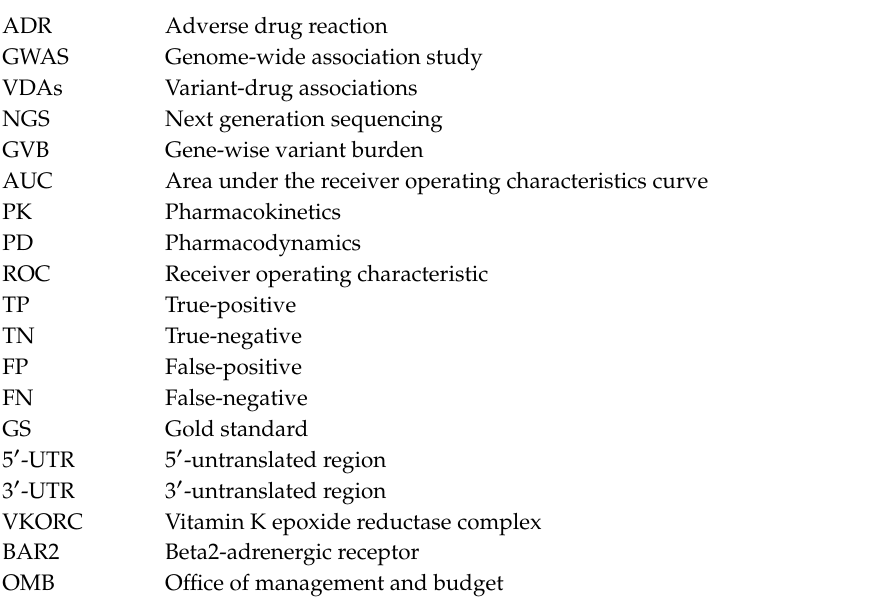
Polyphen-2 HVAR algorithm. Figure S5. Evaluation of di ff erent anatomical main groups using the Polyphen-2 HDIV algorithm. Figure S6. Evaluation of di ff erent anatomical main groups using the PhyloP algorithm. Figure S7. Evaluation of di ff erent anatomical main groups using the GERP ++